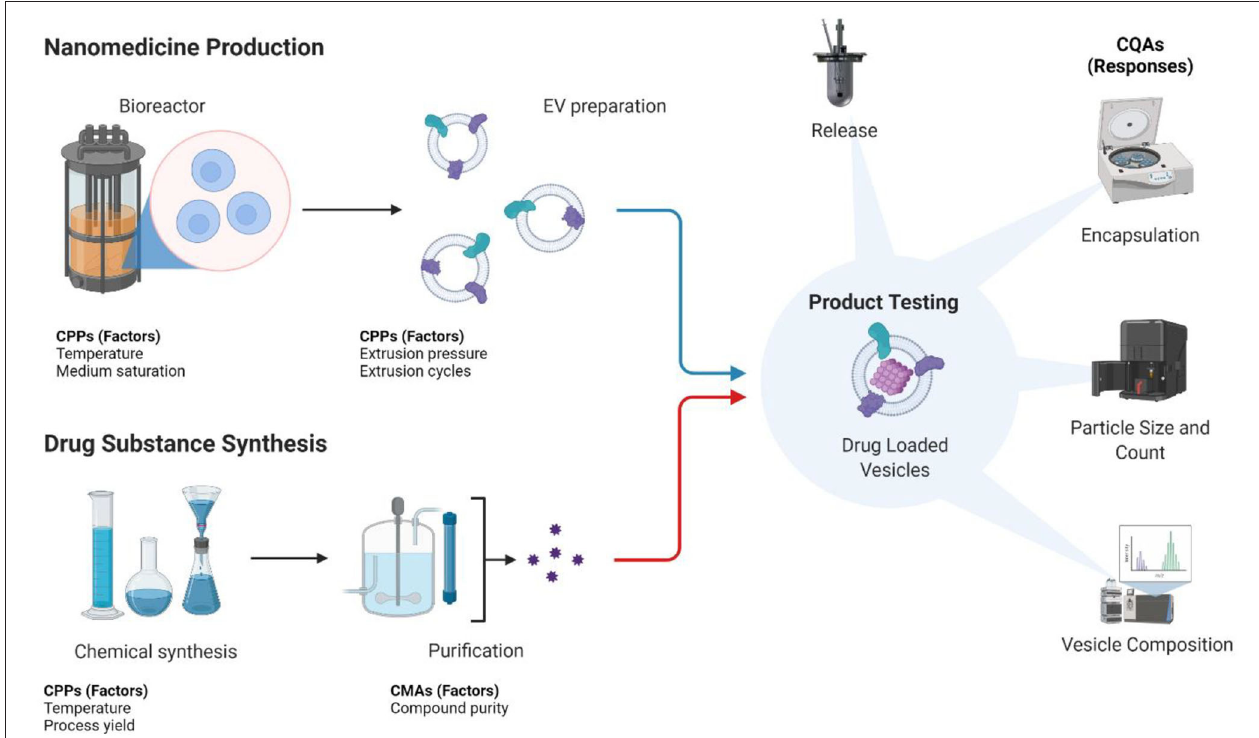
FIGURE 2 | Illustration of nanomedicine production of a drug-loaded extracellular vesicle preparation using a design of experiments approach. Potential CPPs, CMAs, and CQAs are highlighted. Created with